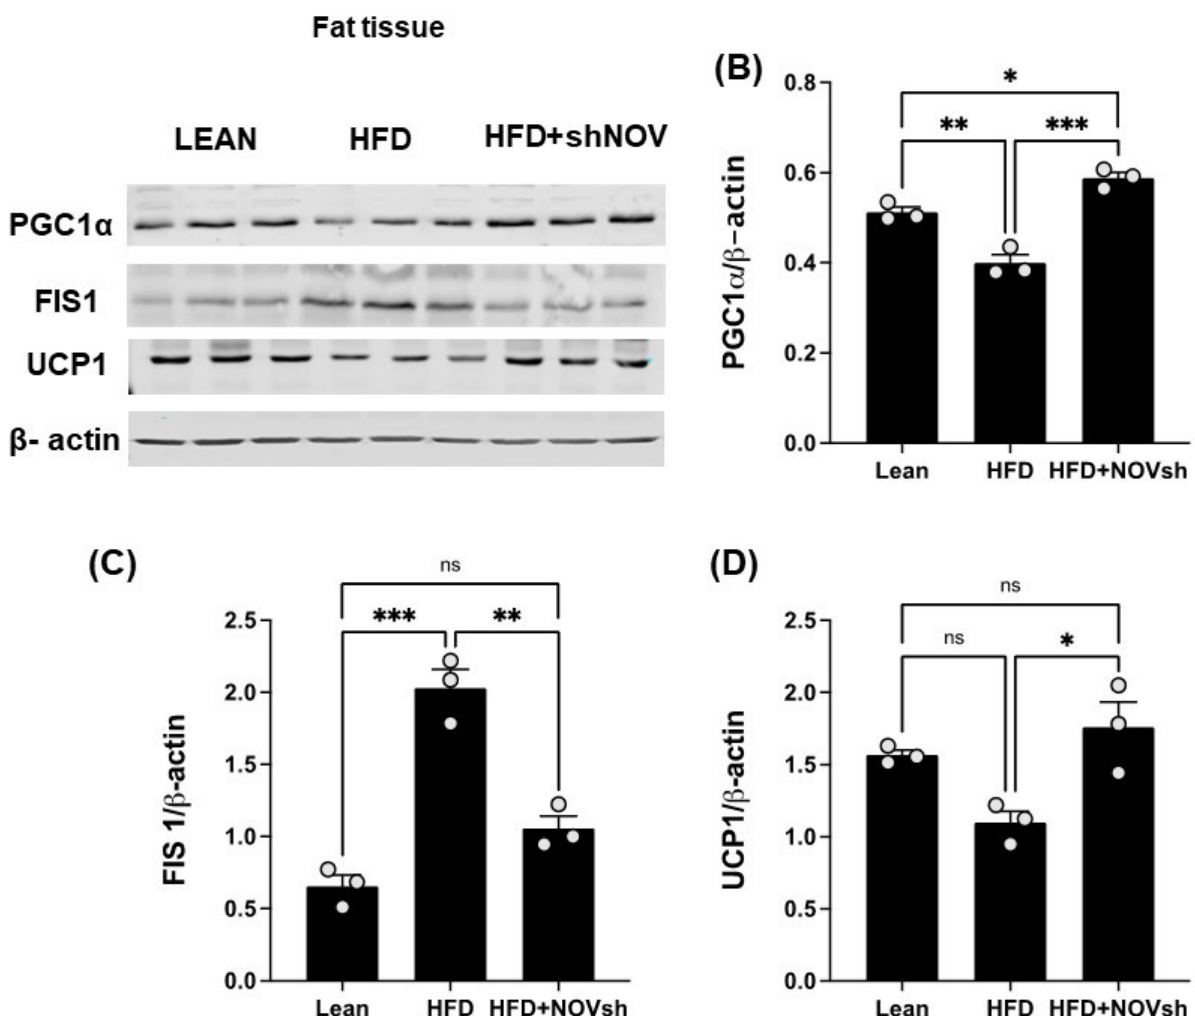
Figure 7. In vivo silencing of NOV with shNOV treatment (NOV knockdown) improves mitochon- drial protein levels and metabolic markers in the adipose tissue. Representative western blot of ( A ): PGC1 α (peroxisome proliferator-activated receptor-gamma coactivator), FIS1 (mitochondrial fission 1 protein), and UCP1 (uncoupling protein 1), and corresponding quantifications ( B – D ) in the adipose tissue of lean, high-fat, and shNOV mice. Results are means ± SE; * p < 0.05, ** p < 0.01, *** p < 0.001, ns = not significant.